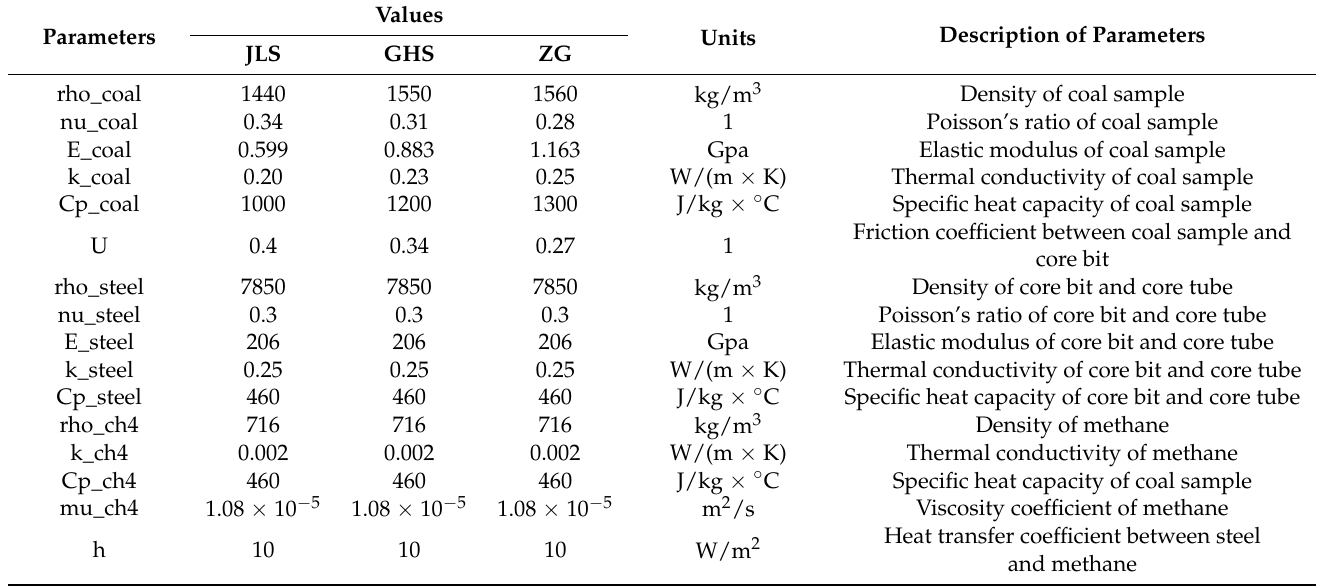
Figure 11. Core bit—core tube physical model: ( a ) temperature core tube model; ( b ) core bit model; and ( c ) integral model of core tube and drill bit. Table 3. Parameters of the model.